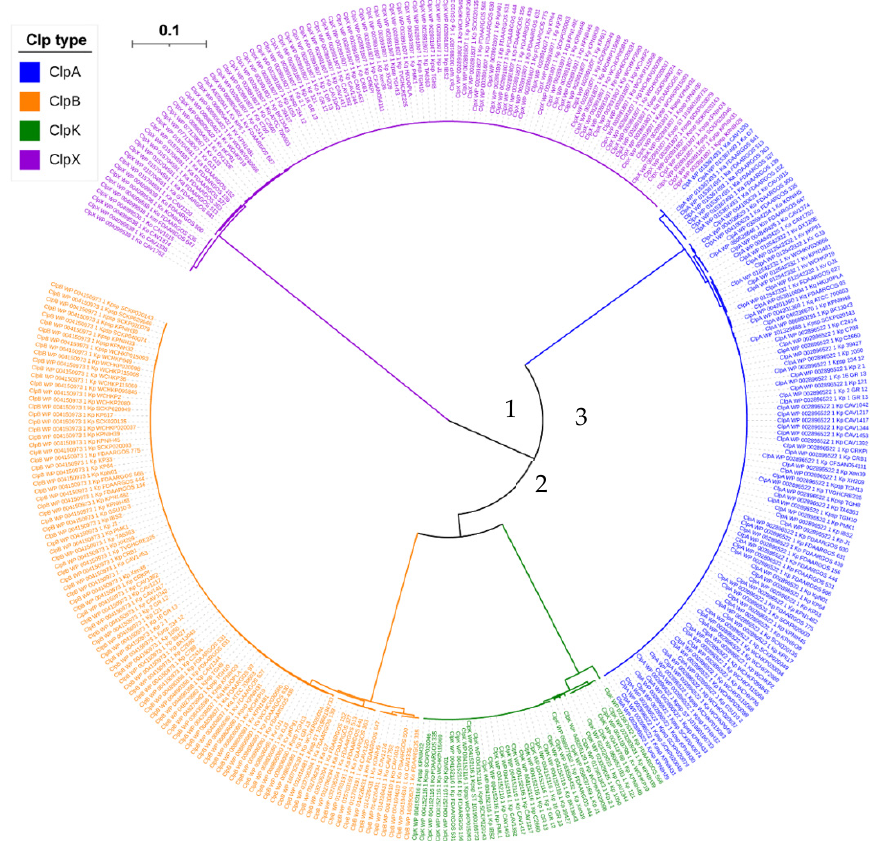
Figure 4. Phylogenetic tree of Clp proteins found among the seven Klebsiella species. MAFFT embedded in Trex servers was used to align the tree. Different Clp proteins are indicated in different colors. Centre of tree (1); point of ClpK and ClpB divergence (2); ClpA (3). Tree distance scale: 0.1.